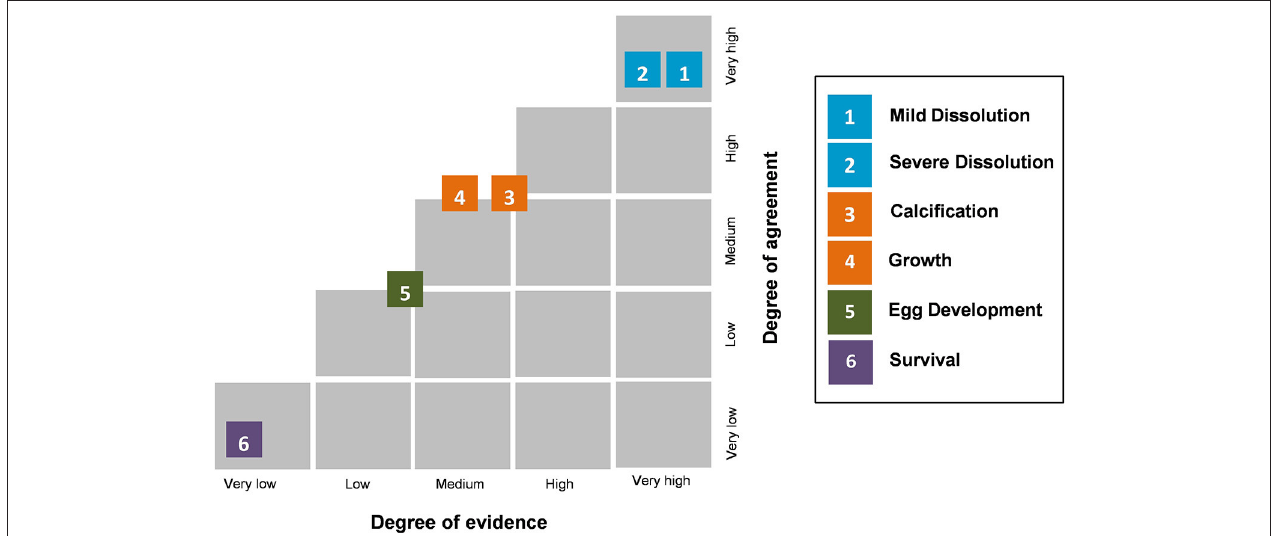
FIGURE 7 | Confidence score based on the combination of evidence and agreement for six different endpoints as determined by the expert consensus. Figure adapted from IPCC 2014